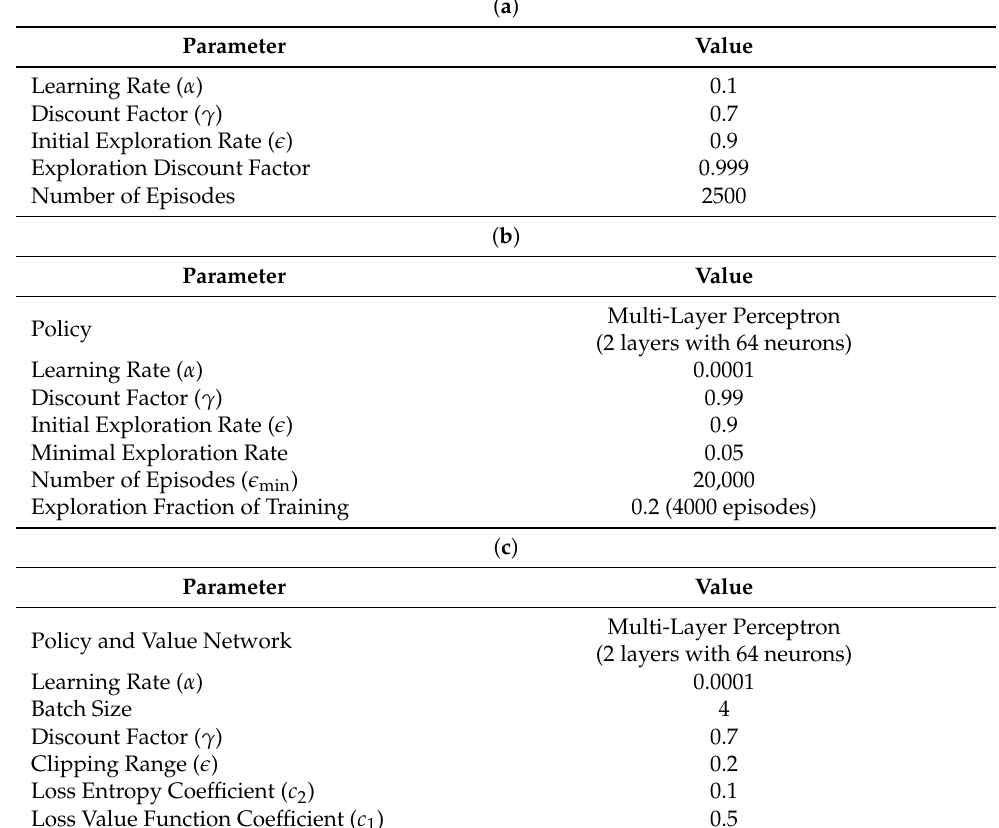
Table 1. Overview of training settings. A detailed introduction of the training parameters is